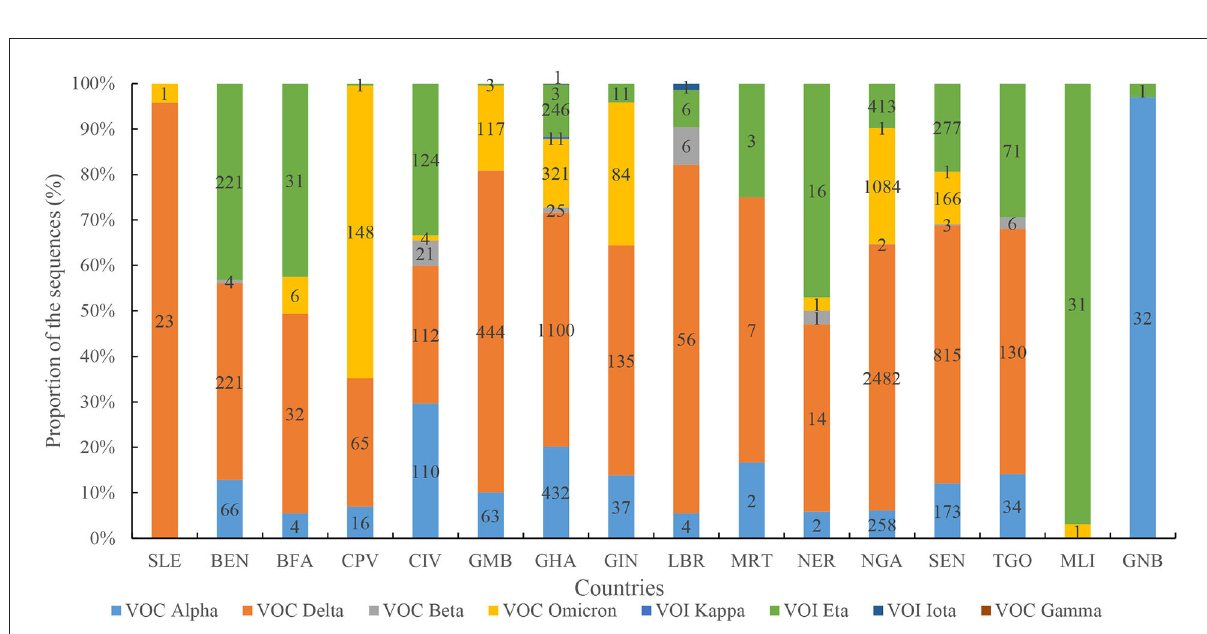
FIGURE8 Diversity profile of SARS-CoV-2 variants in different countries. Note: figures in each column indicates number of the sequences in different SARS-CoV-2 variants.